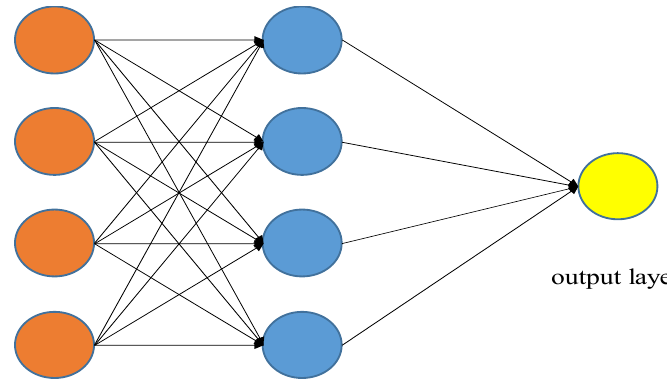
Figure 3. Neural network structure diagram.